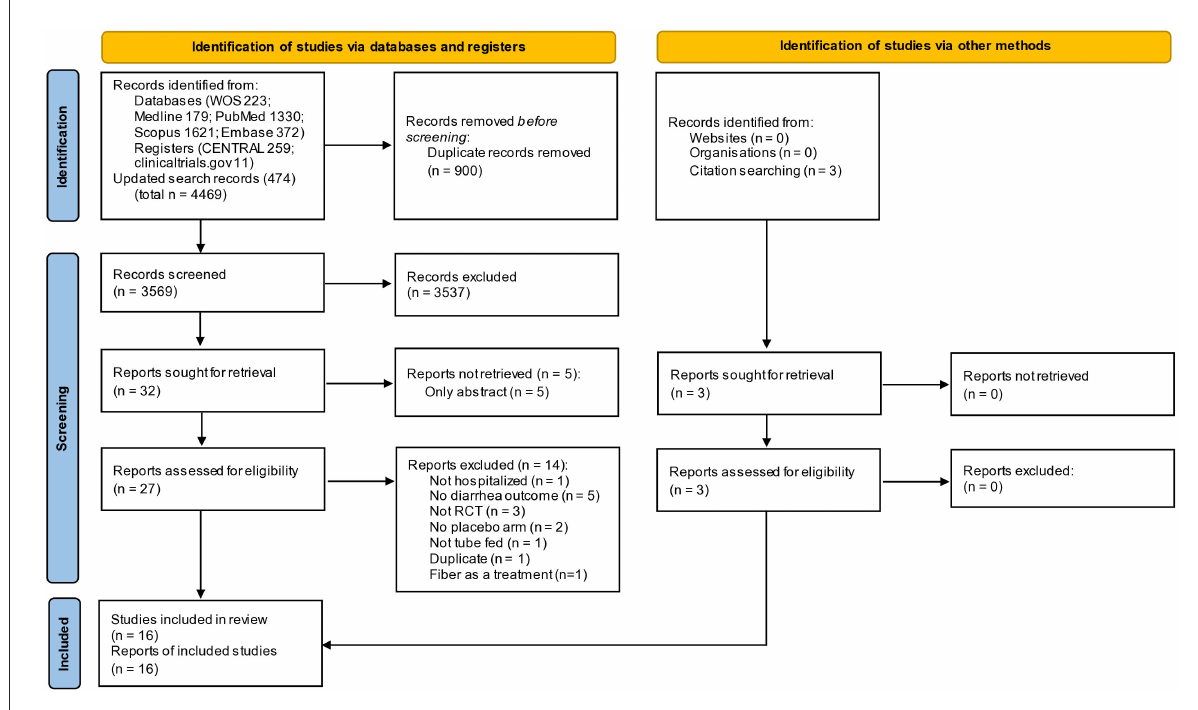
FIGURE1 Preferred reporting items of systematic reviews and meta-analyses (PRISMA) flow